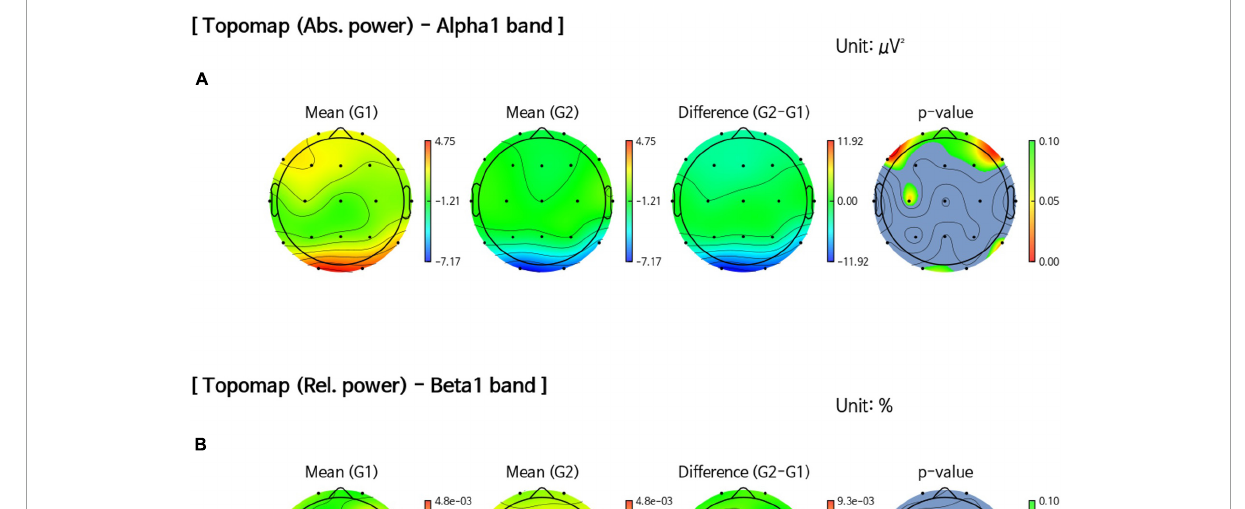
FIGURE2 Comparison of band power changes between all intervention and control groups. (A) Difference between post-intervention and pre-intervention in the control group (G1) showed an increase in the absolute power of the alpha1 band in the frontal, central, and temporal regions than in all intervention groups (G2). (B) An increase in the relative power of the beta1 band in the occipital region ( p = 0.041) after the intervention was observed in all intervention groups (G2) compared with the control group (G1). (C) An increase in the absolute power of the beta3 band in the right parietal region ( p = 0.022) after the intervention was observed in all intervention groups (G2) compared with the control group (G1).